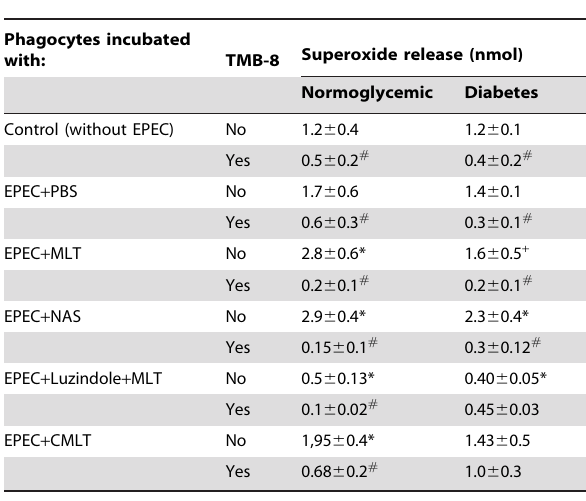
Table 1. Superoxide release by colostrum phagocytes (mean 6 SD, N=8 per